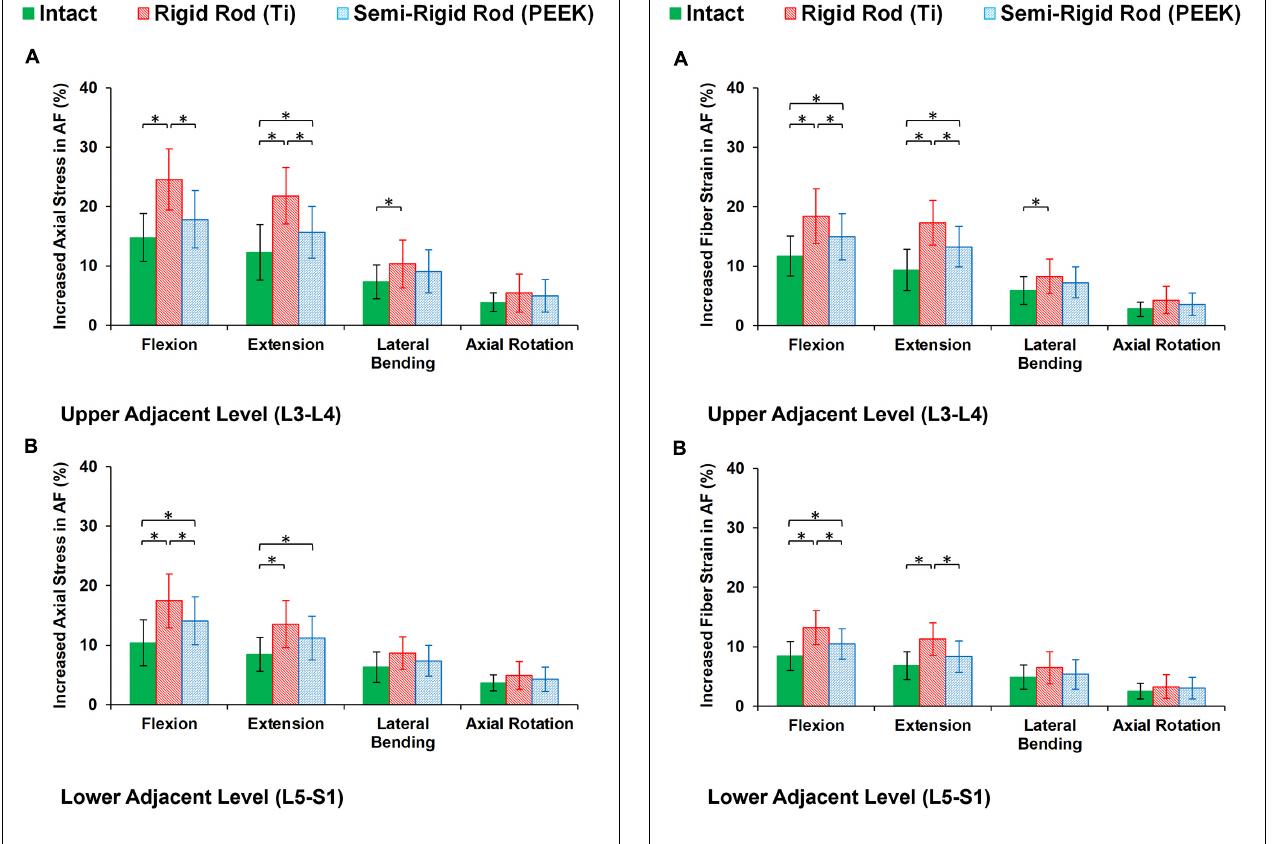
FIGURE 9 | Increased axial stress in annulus fibrosus (AF) for postoperative FE models in the (A) upper adjacent level (L3–L4) and (B) lower adjacent level (L5–S1) in different directions. The reported results in lateral bending and axial rotation are the average in left and right directions. The error bars indicate the standard deviations, and “ ∗ ” shows that p values < 0.05.